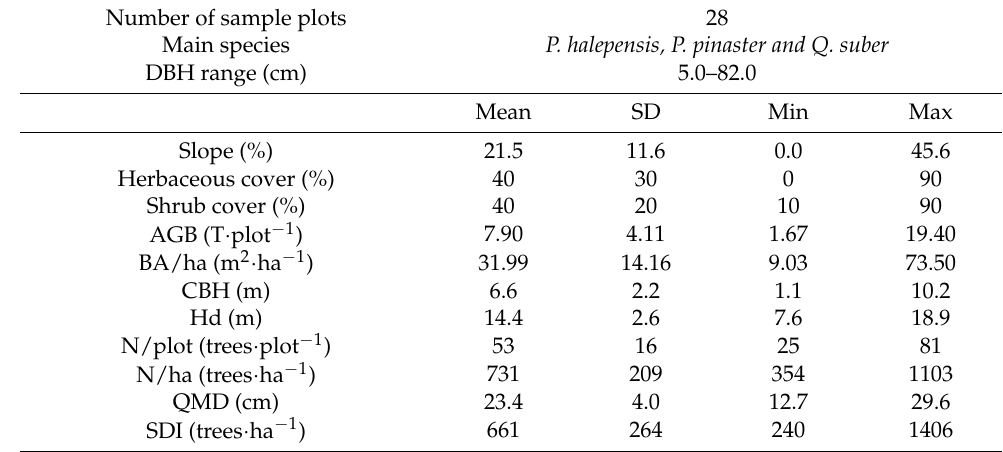
Table 1. Summary statistics of sample plots. Mean, SD, and Min. and Max. refer to the average, standard deviation, and minimum and maximum values, respectively, obtained in the 28 plots.